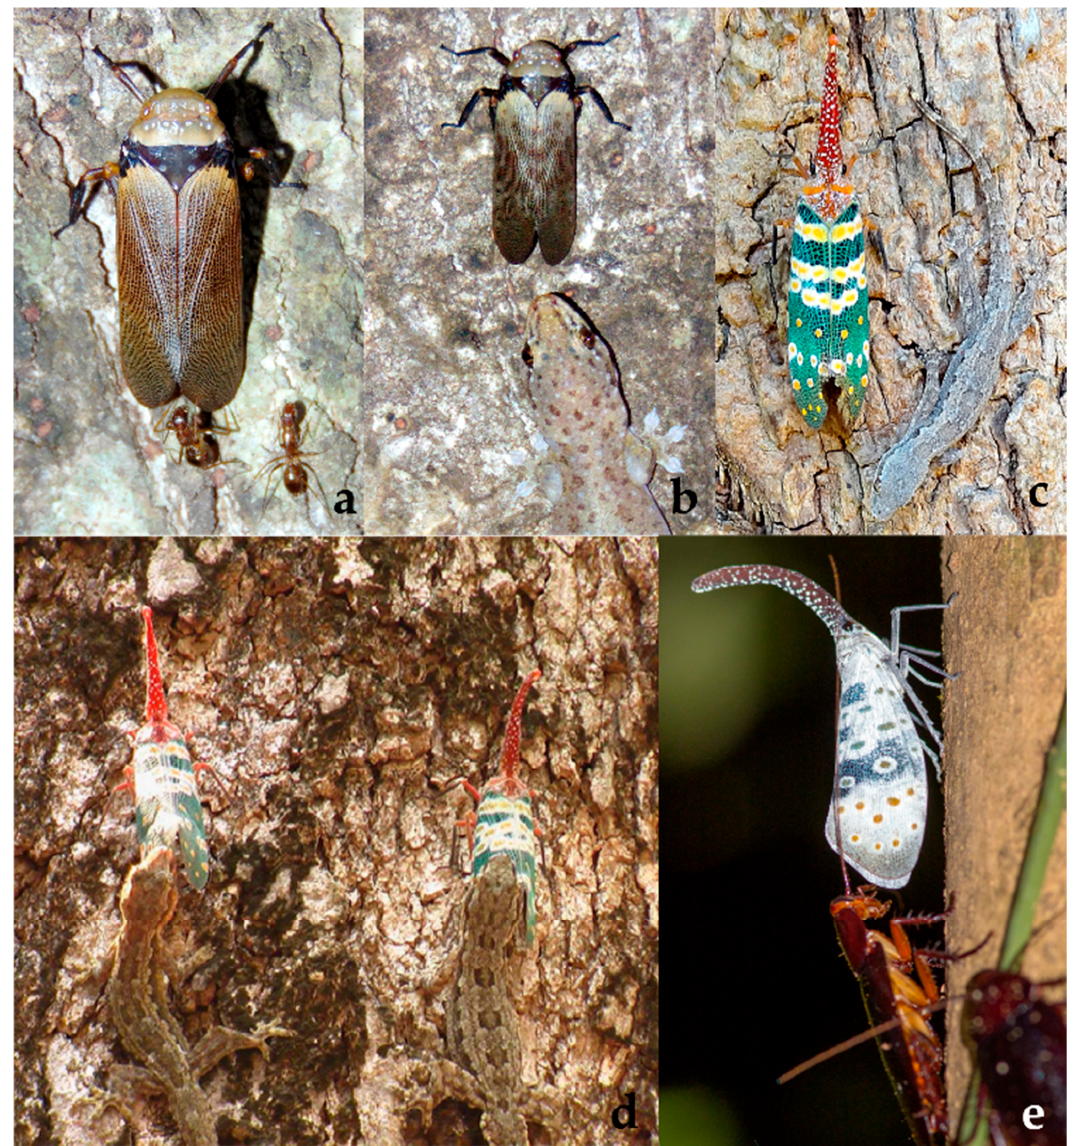
Figure 16. Fulgoridae: ( a ) Polydictya sp. tended by Formicidae indet., Cambodia: Yeak Laom Lake, 13°44 ′ N 107°01 ′ E, 10.10.2017, adult on tree trunk, obs. J. Constant; ( b ) Polydictya sp. tended by Rep- tilia: Squamata: Gekkonidae indet., Cambodia: Yeak Laom Lake, 13°44 ′ N 107°01 ′ E, 10.10.2017, adult on tree trunk, obs. J. Constant; ( c ) Pyrops candelaria (Linné, 1758) tended by Reptilia: Squamata: Gekkonidae indet., Laos: Luang Prabang, Royal Palace Garden, 19°53 ′ 30 ″ N 102°08 ′ 08 ″ E, 05.02.2013, adult on tree trunk, obs. H. Rawson; ( d ) Pyrops candelaria tended by Reptilia: Squamata: Gekkonidae: Hemidactylus platyurus (Schneider, 1797), Thailand, Chiang Mai University Campus, 2006, obs. M. Kemal; ( e ) Pyrops coelestinus (Stål, 1863) tended by Blattodea indet., Vietnam: Cat Tien National Park, 11°26 ′ N 107°26 ′ E, 10.12.2016, adult on tree trunk, obs. D. Gochfeld.